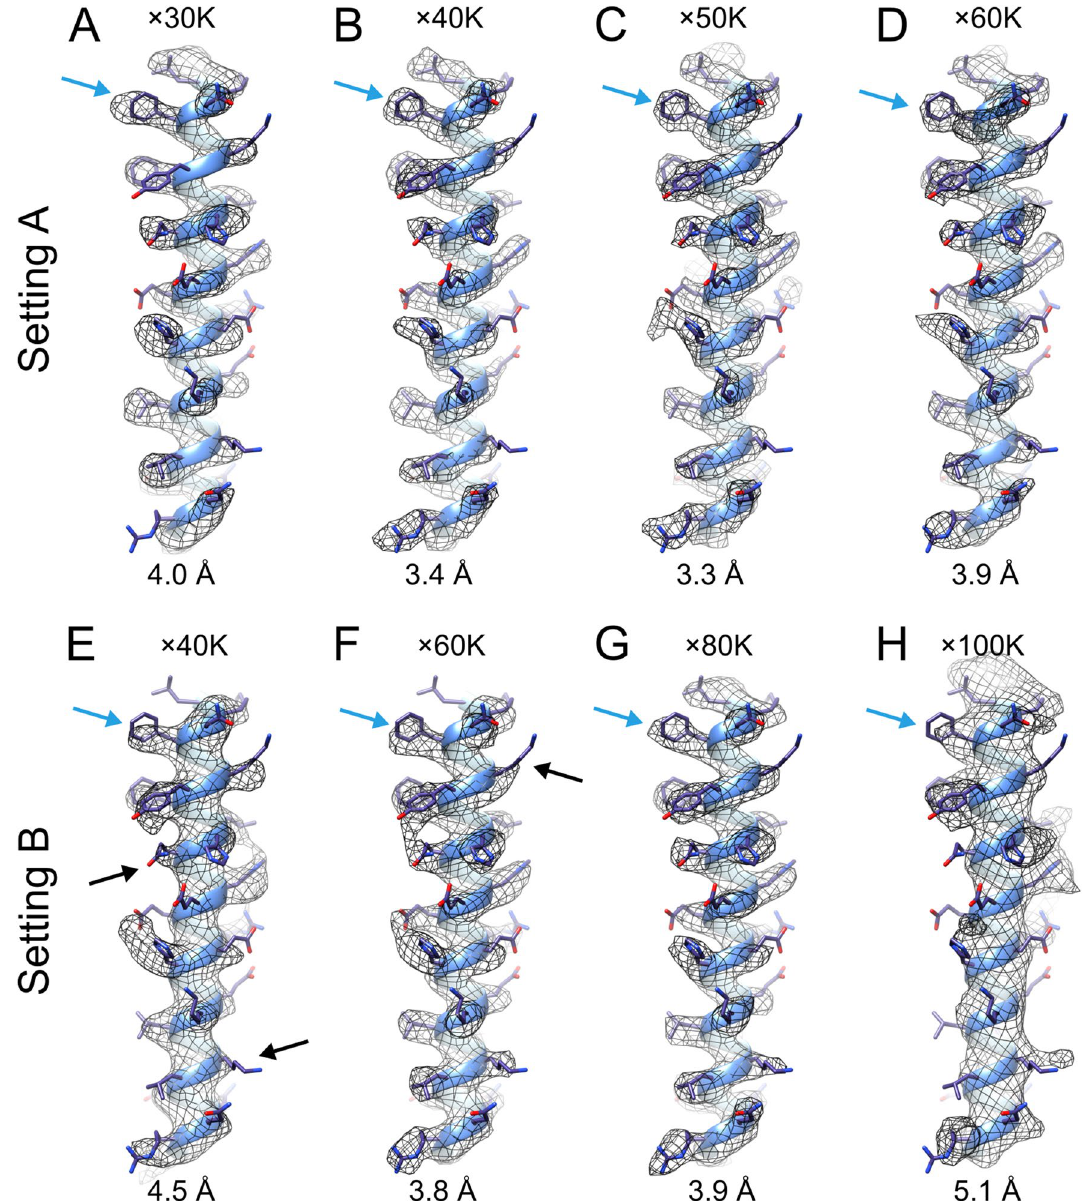
Figure 5. Density comparison between eight reconstruction segments. A representative α-helix (Leu48- Arg77) was extracted from each cryo-EM map and the corresponding atomic model (PDB ID: 2CIH) was rigid-body fitted to each map. The maps in the top panel are reconstructed from datasets acquired by Setting A, at magnifications of × 30 K ( A ), × 40 K ( B ), × 50 K ( C ), and × 60 K ( D ). The maps in each bottom panel are reconstructed from datasets acquired by Setting B, at magnifications of × 40 K ( E ), × 60 K ( F ), × 80 K ( G ), and × 100 K ( H ). The obtained resolutions are labelled in each map. Phe51 is indicated by blue arrows. Black arrows highlight exemplar sidechains which may present difficulties in